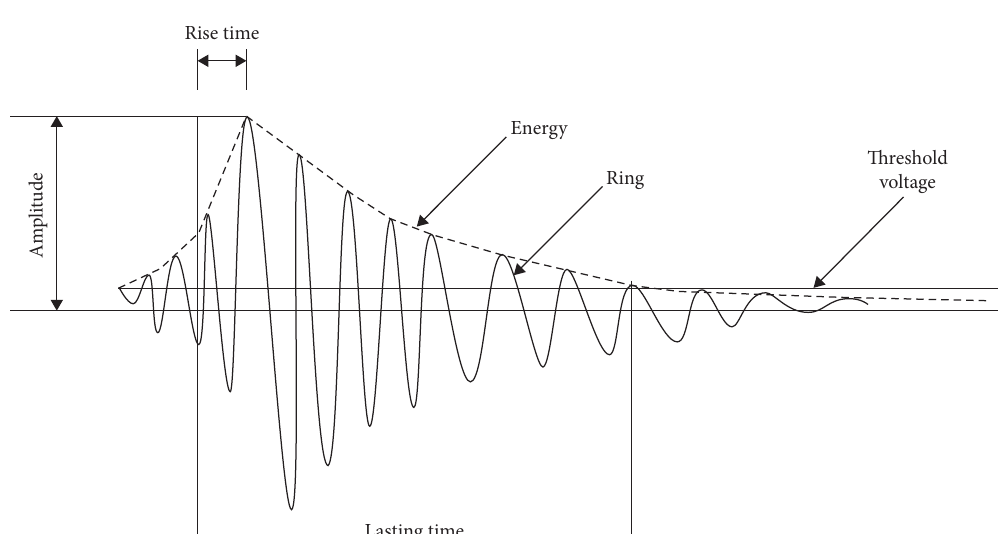
Figure 3: AE test method.